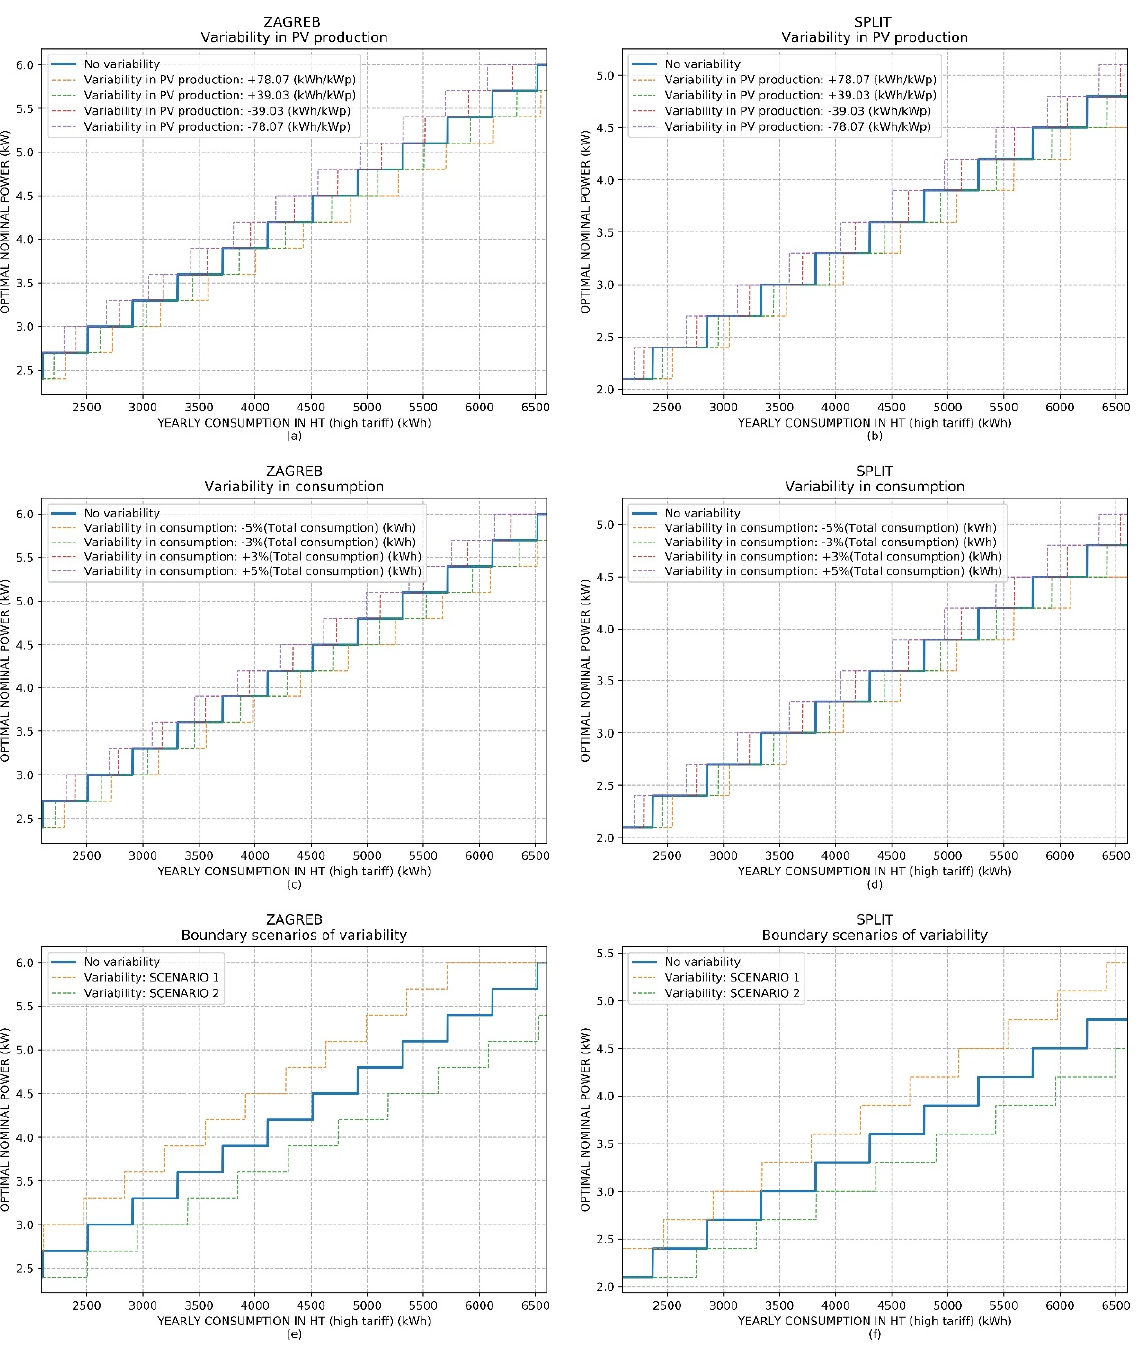
Figure 8. The optimal nominal power of a PV system: ( a ) Variability in PV production for Zagreb. ( b ) Variability in PV production for Split. ( c ) Variability in total consumption for Zagreb. ( d ) Variability in total consumption for Split. ( e ) Boundary scenarios of variability for Zagreb. ( f ) Boundary scenarios of variability for Split.